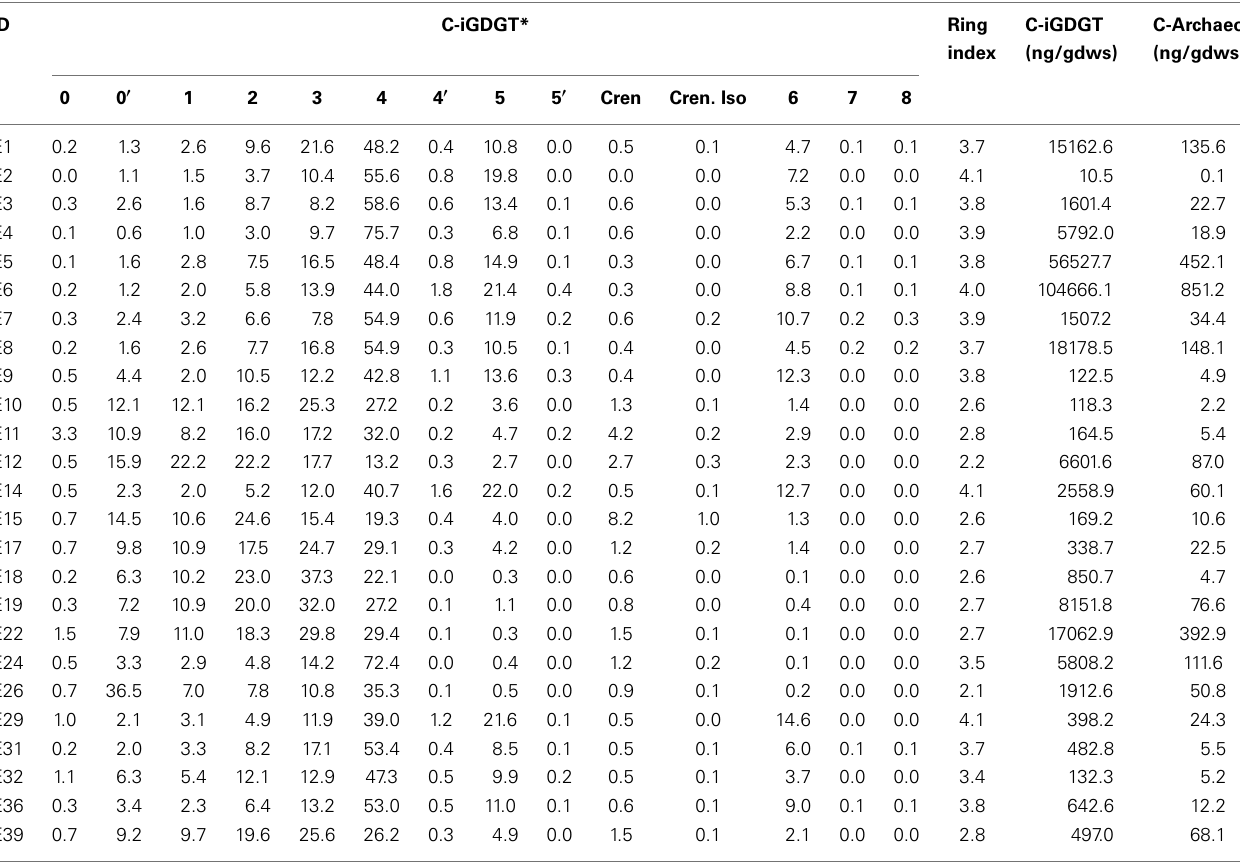
Table 2 | Relative abundance of C-iGDGT lipids in geothermal mat and sediment